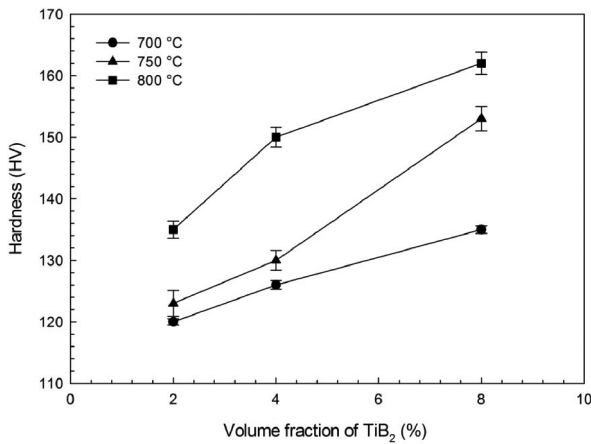
Fig. 6: Hardness of the composites produced under different production temperatures as a function of TiB 2 content